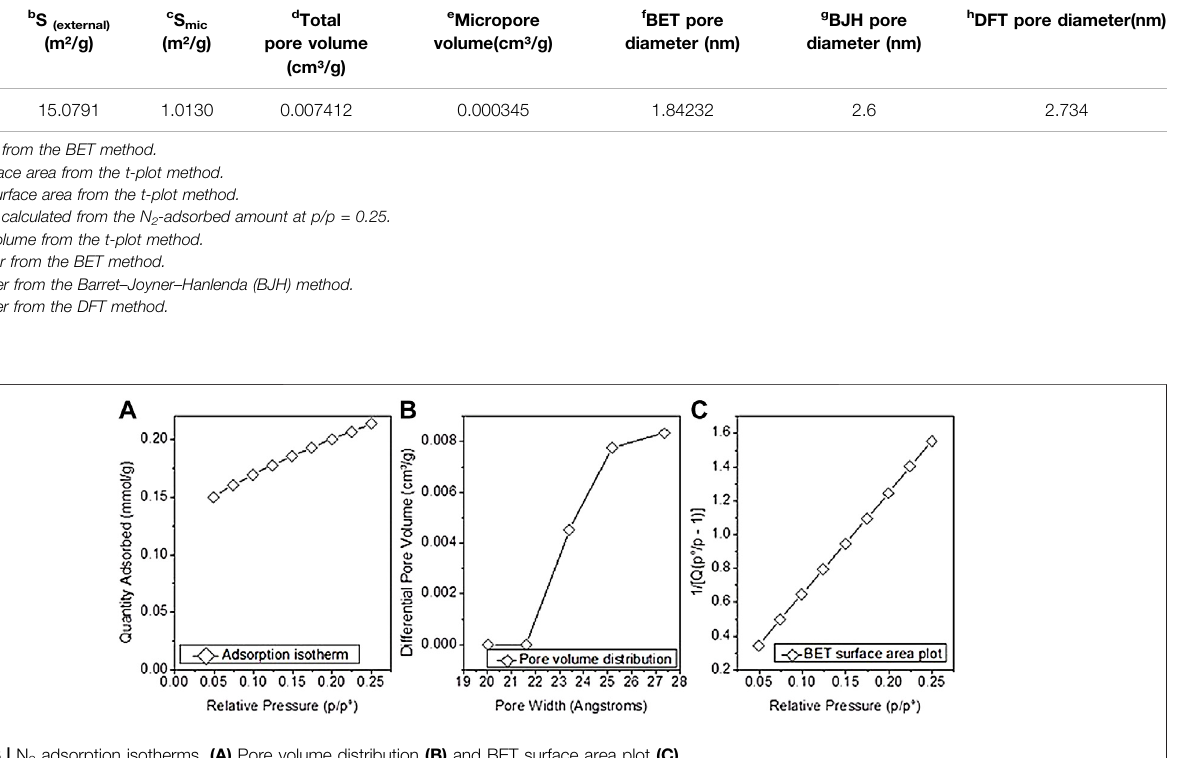
TABLE 1 | Physical characteristics of the poultry manure-derived biochar.